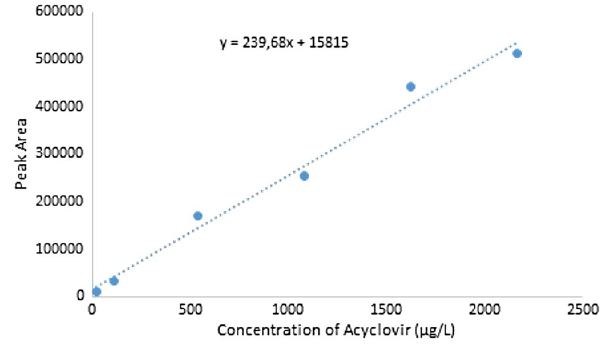
Figure 12. Calibration curve of acyclovir.